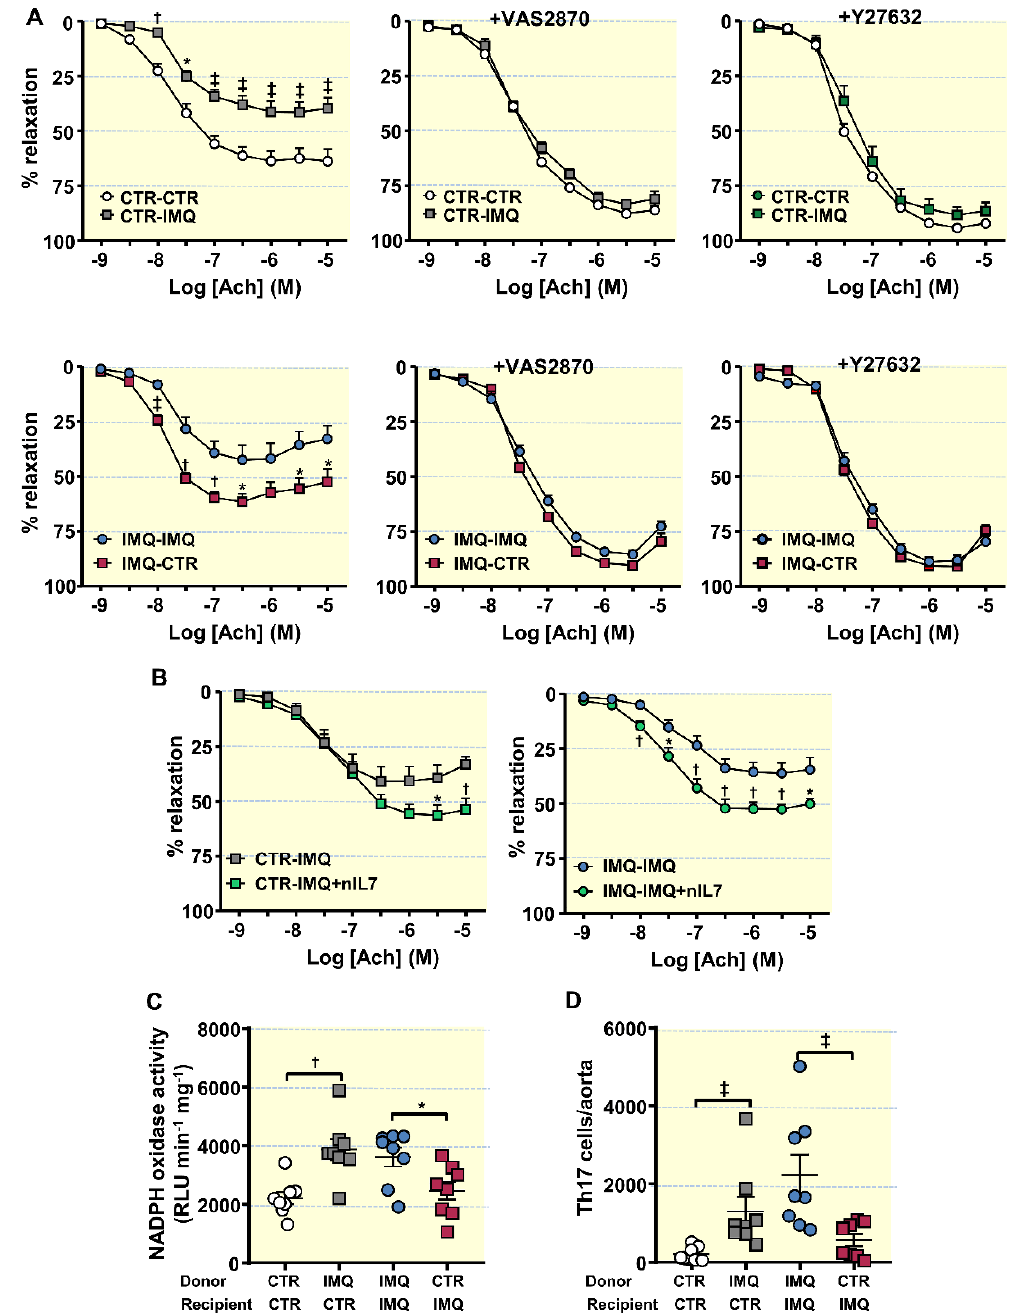
Figure 6. Effects of the microbiota transplants on endothelial function, NADPH oxidase activity and infiltration of T lymphocytes in aorta. ( A ) Acetylcholine (Ach)-induced relaxation curves in aortas pre-contracted with U46619 (10 nM) with or without the specific pan-NOX inhibitor VAS2870 (1 µ M), or the Rho kinase inhibitor Y27632 (1 µ M). ( B ) Acetylcholine (Ach)-induced relaxation curves with or without anti-IL-17a antibody (10 µ g · mL) in segments from control (CTR) and Imiquimod-treated (IMQ) recipient mice, transplanted with microbiota from IMQ animals. ( C ) NADPH oxidase activity determined via lucigenin-enhanced chemiluminescence. ( D ) Aortic infiltration of T helper(h)17 through flow cytometry. Values are represented as means ± SEM. The concentration-response curves to Ach were analysed by two-way ANOVA with the Tukey’s multiple comparison test. The rest of the variables were tested with unpaired t -test. * p < 0.05, † p < 0.01, ‡ p < 0.001 compared to the CTR-CTR group; * p < 0.05, † p < 0.01, ‡ p < 0.001 compared to IMQ-IMQ group CTR-CTR, Control mice (CTR) transplanted with microbiota from CTR; CTR-IMQ, CTR transplanted with microbiota from imiquimod (IMQ)-treated mice; IMQ-IMQ, IMQ transplanted with microbiota from IMQ; and IMQ-CTR, IMQ transplanted with microbiota from